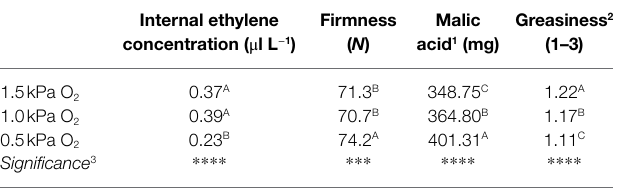
TABLE 6 | Greasiness of ‘Gala’ apples treated without or with postharvest 1-MCP (1 μ l L -1 ) for 24 h at harvest or after storage in 1.5, 1.0 or 0.5